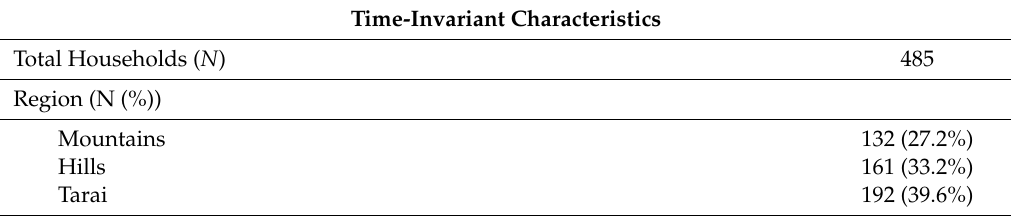
Table 1. Characteristics of Nepali subsistence farming households observed at up to four di ff erent time